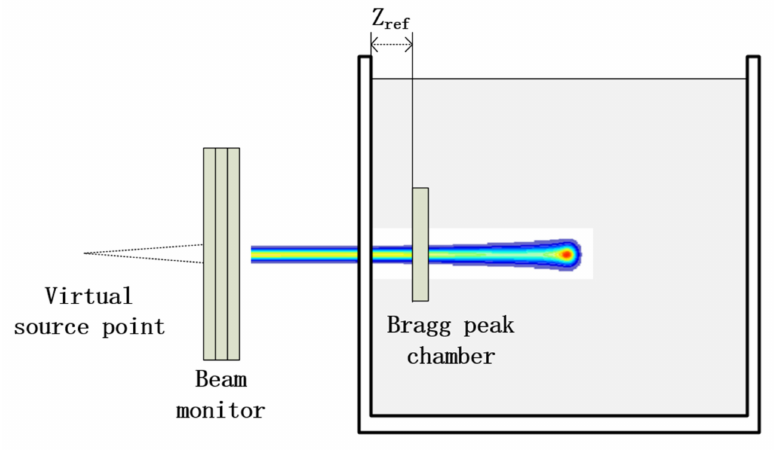
Figure 2. Illustration of the setup for the DAP measurement in water with the single-spot method. DAP measured with BPC in a beamlet, DAP A